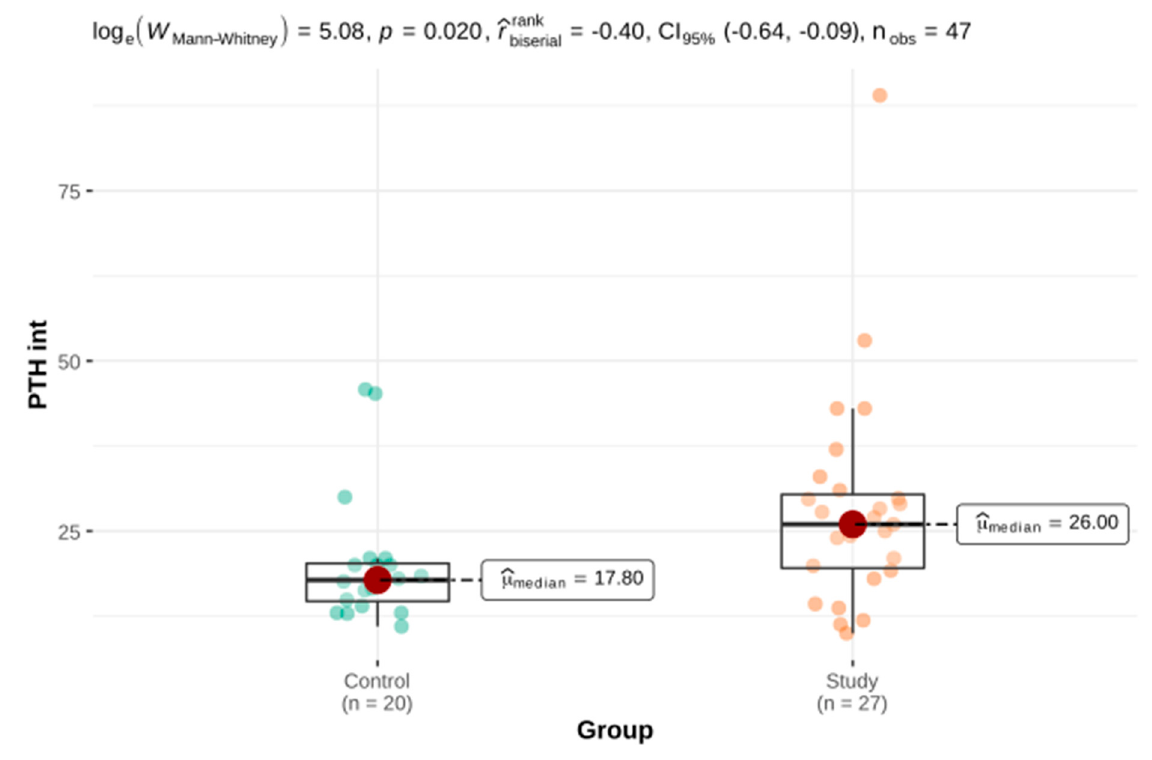
Figure 3. The serum intact parathyroid hormone (PTH int) concentration in the study and the control groups.